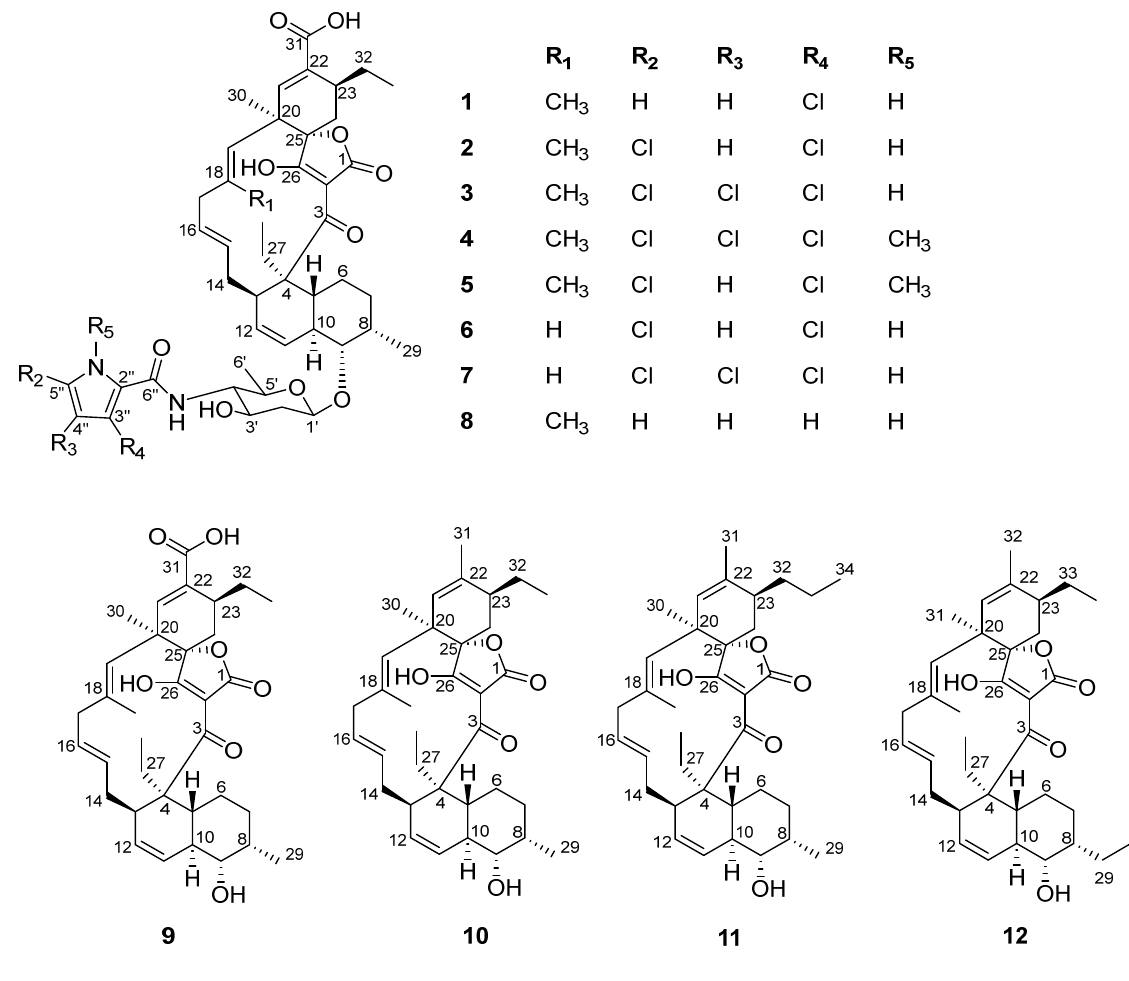
Figure 1. Chemical structures of compounds 1 – 12 .